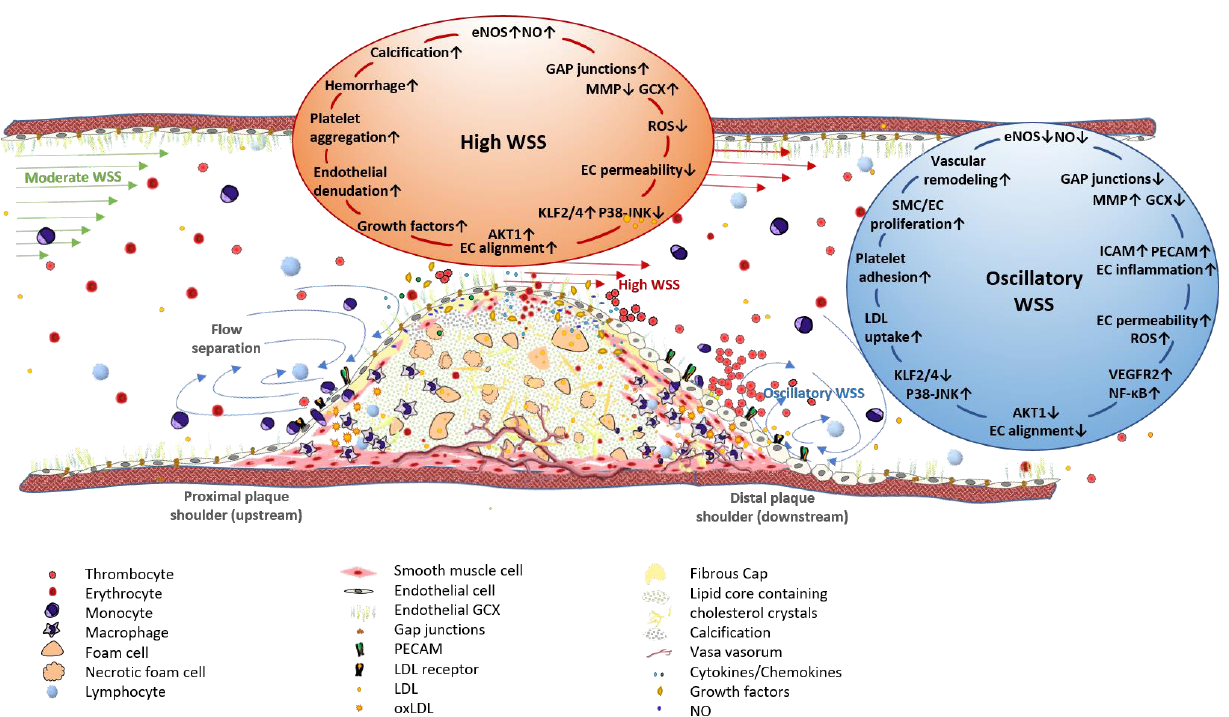
Figure 3. Association of WSS patterns of the arterial wall with plaque progression and vulnerability. Vessel stenosis caused by an advanced atherosclerotic lesion changes local WSS patterns. Moderate WSS, to which straight vessel segments are exposed, changes to high WSS at the throat of an arterial obstruction, whereas the downstream plaque shoulder is exposed to oscillatory WSS, characterized by flow separation and bidirectional flow. The endothelium, affected by high WSS, exhibits enhanced NO production due to mechanoactivation of eNOS, which is induced by the antiinflammatory transcription factor KLF2. Additionally, ECs show an axial alignment in the direction of blood flow, an almost intact GLX, and the low expression levels of adhesion molecules, such as PECAM and ICAM-1. Apart from its potentially atheroprotective effects, high WSS can promote plaque vulnerability by inducing platelet aggregation and endothelial denudation. Furthermore, plaques in vessel segments exposed to high WSS are characterized by enhanced intimal calcification. Oscillatory WSS is involved in plaque initiation and progression through the induction of EC and SMC proliferation and migration. Mechanoactivation of NF- ᴋ B results in the increased expression of diverse proinflammatory genes, i.e., adhesion molecules and receptors for LDL uptake. EC alignment is inhibited and cells show a cobblestone-like morphology and increased permeability. Enhanced eGCX shedding due to increased MMP or sheddase levels facilitates the infiltration of immune cells from peripheral blood into the vessel wall. EC: endothelial cell, eNOS: endothelial nitric oxide synthase, GCX: glycocalyx, ICAM-1: intercellular adhesion molecule 1, KLF2: Krüppel-like factor 2, LDL: low density lipoprotein, NO: nitic oxide, PECAM: platelet endothelial cell adhesion molecule, SMC: smooth muscle cell, WSS: wall shear stress, ↑ : upregulation, ↓ :